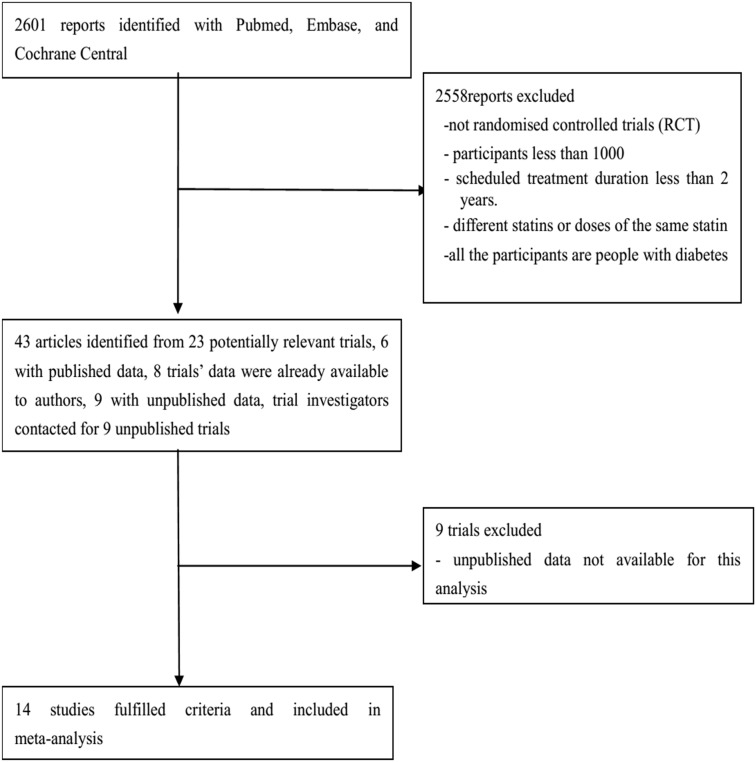
Flow diagram of literature search to identify randomised placebo-controlled and standard care-controlled statin trials.